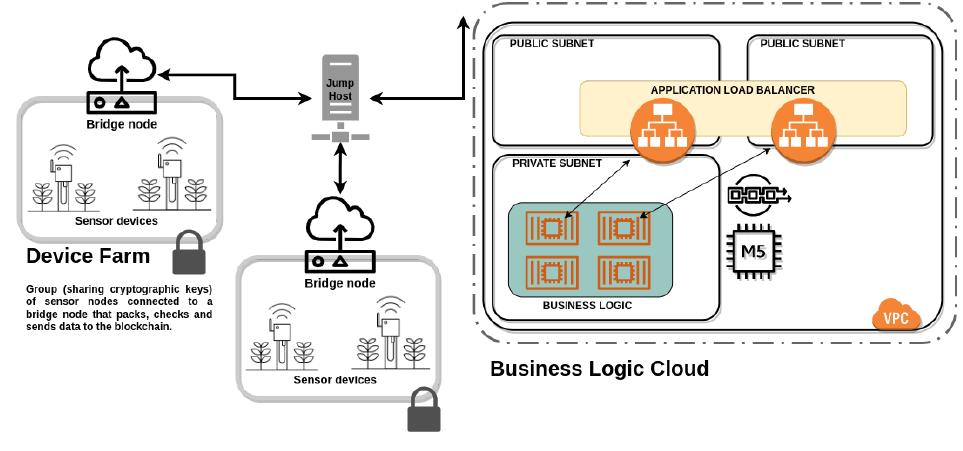
Figure 1. Computing infrastructure.